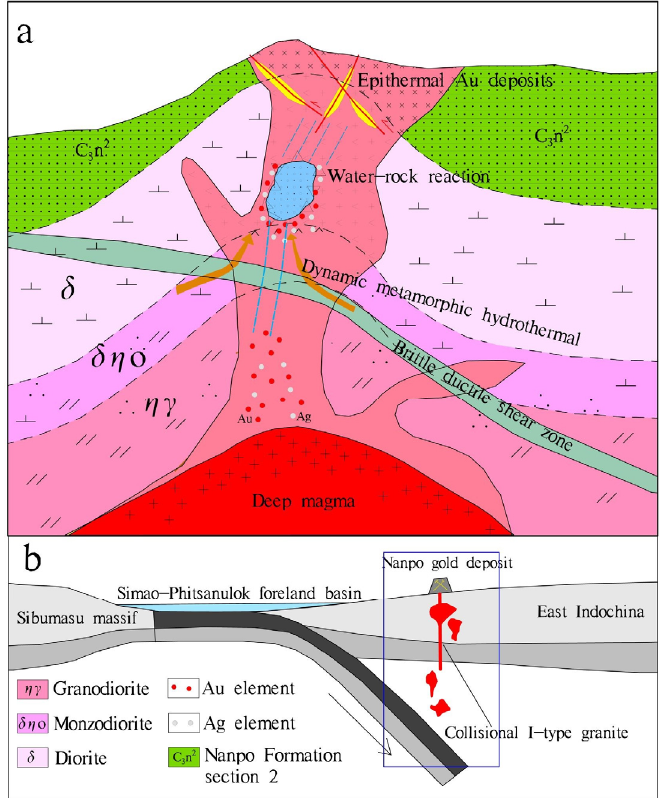
Figure 8. ( a ) Generalized mineralization model of the Nanpo gold deposit in the Luang Prabang–Loei island arc belt of Laos; ( b ) sketched map of Indosinian volcanism caused by eastward subduction of the Paleo-Tethys Ocean (modified from [13–21,34,43]).